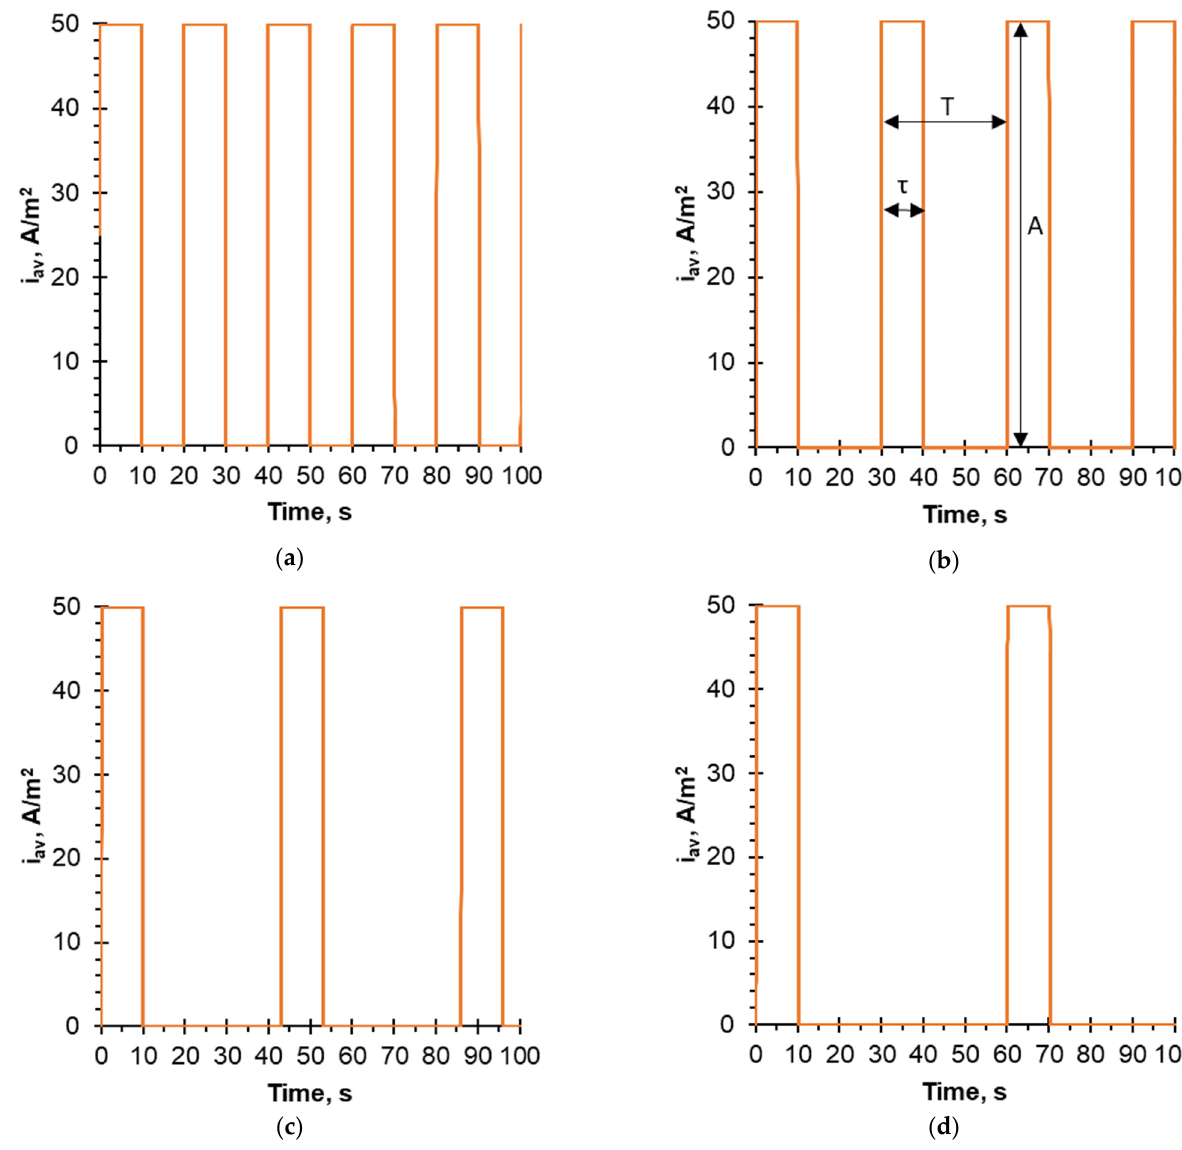
Figure 1. Time dependences of the current density for the PEF pulse-pause durations: ( a ) 10 s-10 s; ( b ) 10 s-20 s; ( c ) 10 s-33 s; ( d ) 10 s-50 s, where τ is the pulse duration, T is the pulse period (single pulse and single pause duration), and A is the pulse amplitude.